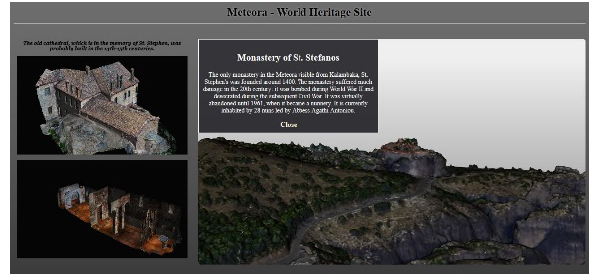
Figure 10. Screenshot from the display of text and 3D models of archaeologic and architectural interest via the METEORA platform